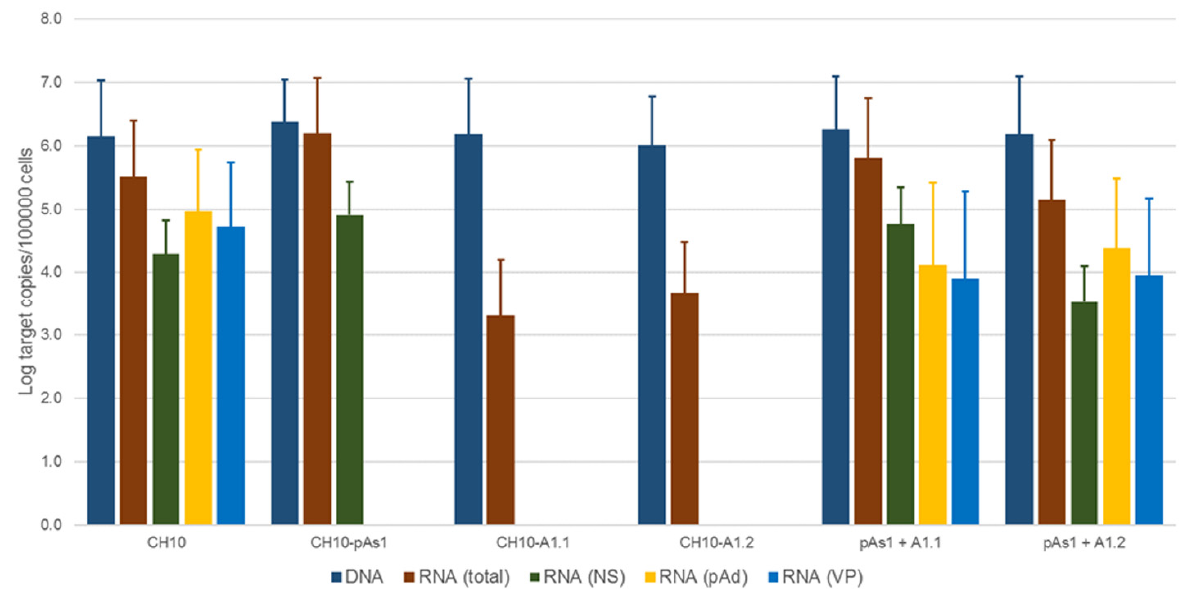
Figure 7. Viral nucleic acids in UT7/EpoS1 cells, transfected/co-transfected with CH10, CH10-pAs1 and CH10-A1.1/2 inserts. Log amounts of target copies (viral DNA, total RNA, NS1 mRNA, pAd cleaved RNA, VP RNA), normalized to 10 5 cells, at 24 hpt. Mean and std of duplicate determinations for two different experiments.